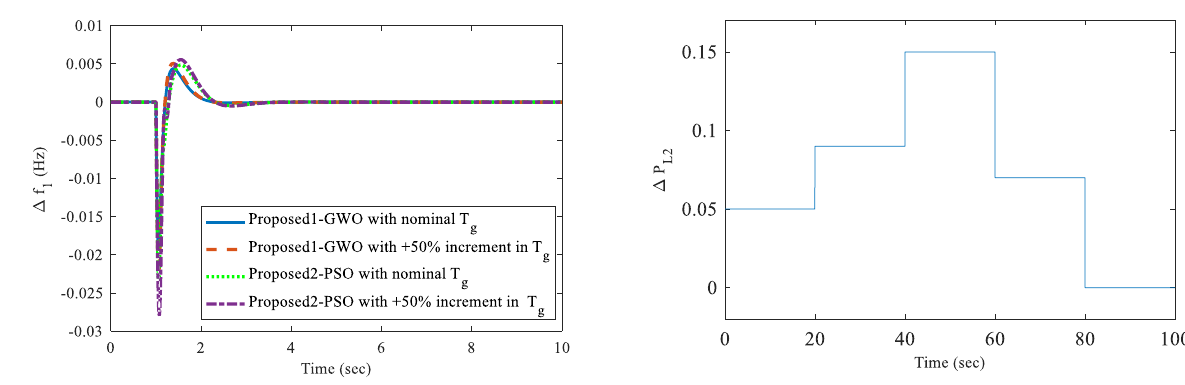
Fig. 21 Random step loading in area 2 for case 5e under case study 5